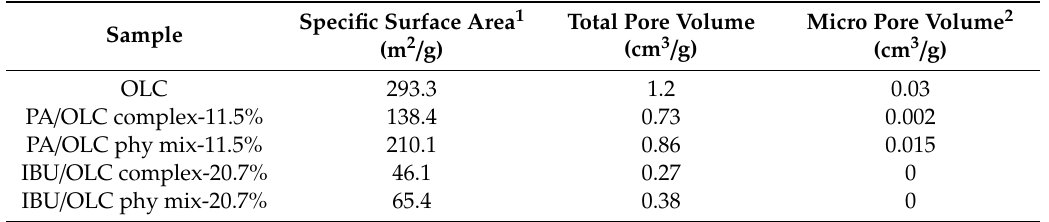
Table 3. Surface areas and pore volumes obtained from nitrogen sorption of carbon onion (OLC), ibuprofen-loaded carbon onion (IBU/OLC complex) and paracetamol loaded carbon onion (PA/OLC complex).